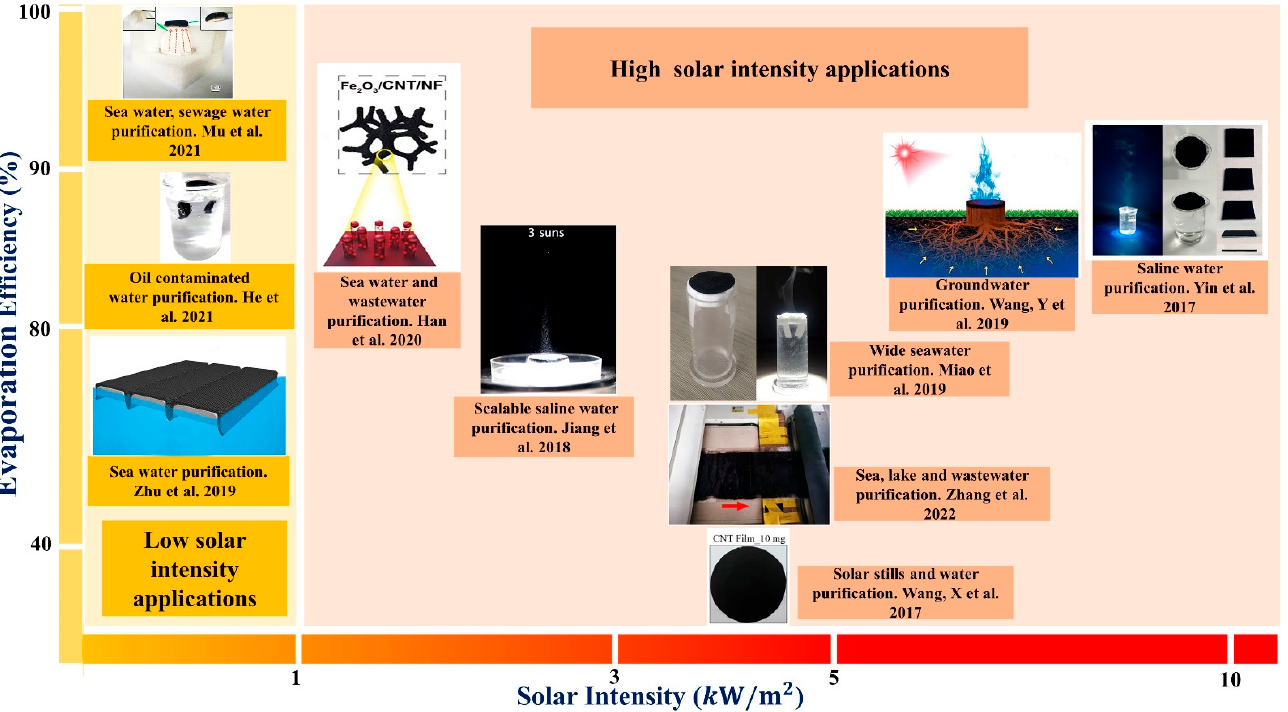
Figure 3. Mapping of applications for CNT-based solar thermal devices based on solar intensity in relation to evaporation efficiency (reproduced with permission, Copyright 2020 Elsevier [40]; reproduced with permission, Copyright 2017 The Royal Society of Chemistry [41]; reproduced with permission, Copyright 2019 American Chemical Society [42]; reproduced with permission, Copyright 2020 American Chemical Society [43]; reproduced with permission, Copyright 2018 American Chemical Society [44]; reproduced with permission, Copyright 2019 Elsevier [45]; reproduced with permission, Copyright 2022 American Chemical Society [46]; reproduced with permission, Copyright 2017 Elsevier [47]; reproduced with permission, Copyright 2018 John Wiley and Sons [48]; reproduced with permission, Copyright 2017 American Chemical Society [49]).